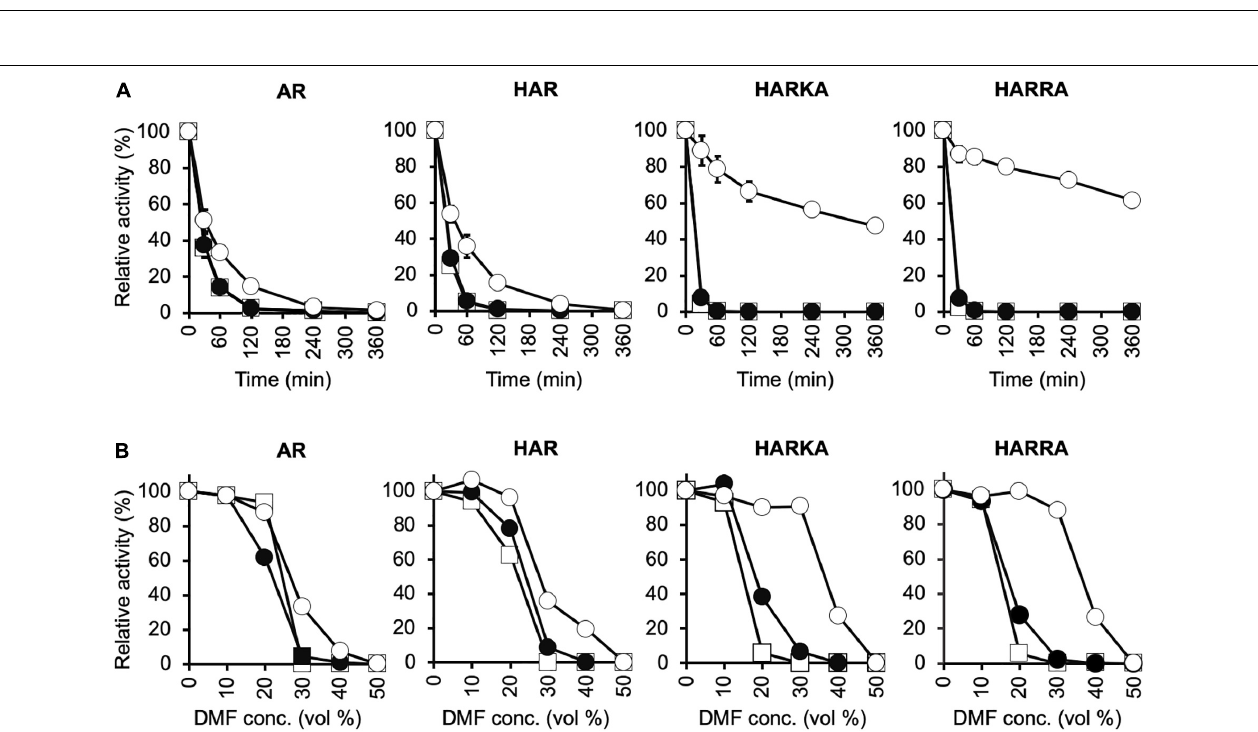
FIGURE 2 | The temperature dependence profiles of the wild-type and mutant RsPtxD proteins. Each protein’s activity was measured using NAD (filled circles) or NADP (open circles) as a nicotinamide cofactor. The data are shown as means ± standard deviation obtained from three independent experiments. WT, wild-type;